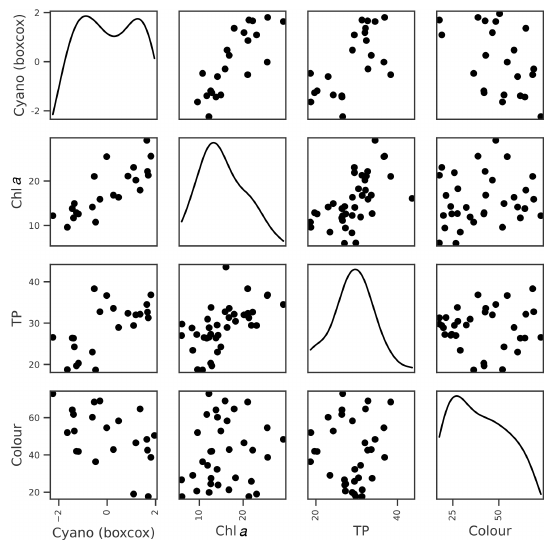
Figure 5. Relationships between Box–Cox-transformed seasonal maximum cyanobacteria biovolume and potential explanatory vari- ables of interest, including seasonal means in lake chl a , TP, and colour. Density plots estimated using kde are shown along the diag-